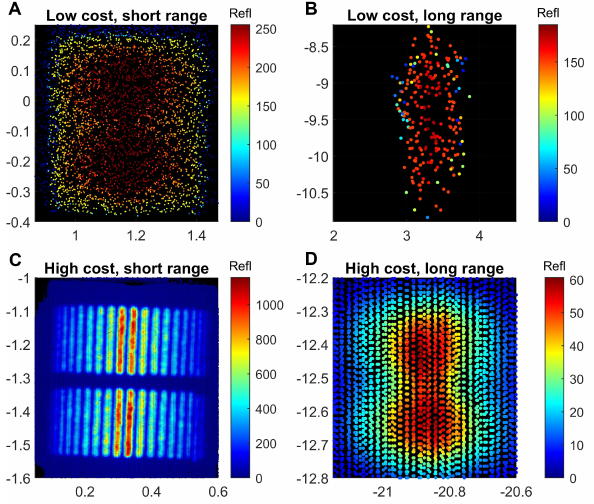
Figure 5: Point clouds obtained from lidar measurements on mar- itime navigational aids. Short range equals to 50 m and long range equals to 500 m. The x and y axes are in meters. Note that the intensity scales are not identical. The sensors have roughly two orders of magnitude difference in price, but this is at least par- tially attributable to highly sophisticated software for the high cost sensor. Based on data from [Malkam¨aki et al.,